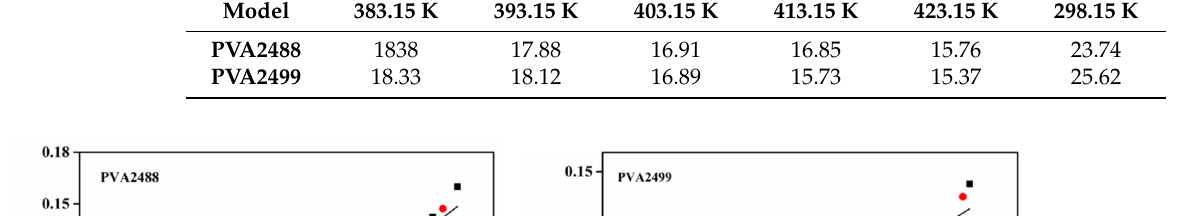
Figure 3. Calculation of PVA solubility parameter ( δ 2 ) at 298.15 K by extrapolation. Table 5. Solubility parameters δ (cid:2870) of PVA at different temperatures ((J/cm − 3 ) 0.5 ). Model